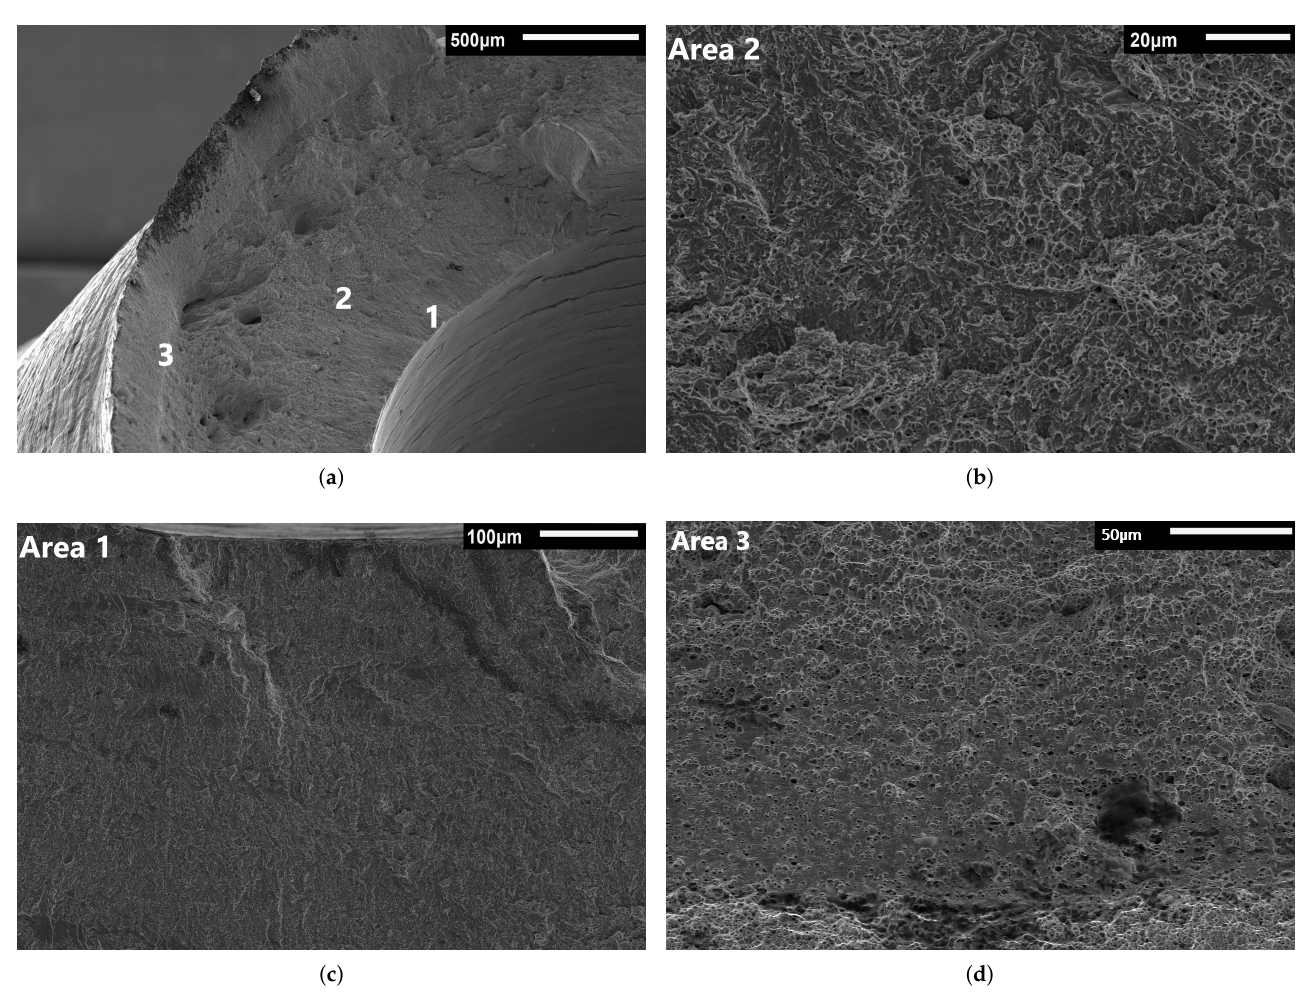
Figure 10. SEM Fractographic images of a notched weld metal samples tested in 70 barg H 2 . ( a ) Showing the macroscopic fracture morphology. ( b ) A magnified image of the fracture surface at area 2 as indicated in ( a ) in the transition zone between quasi-cleavage and microvoid coalescence fracture. ( c ) An overview of an area equivalent to 1 of the inside wall showing pure quasi-cleavage fracture. ( d ) An overview of an area equivalent to 3 of the outside wall showing microvoid coalescence